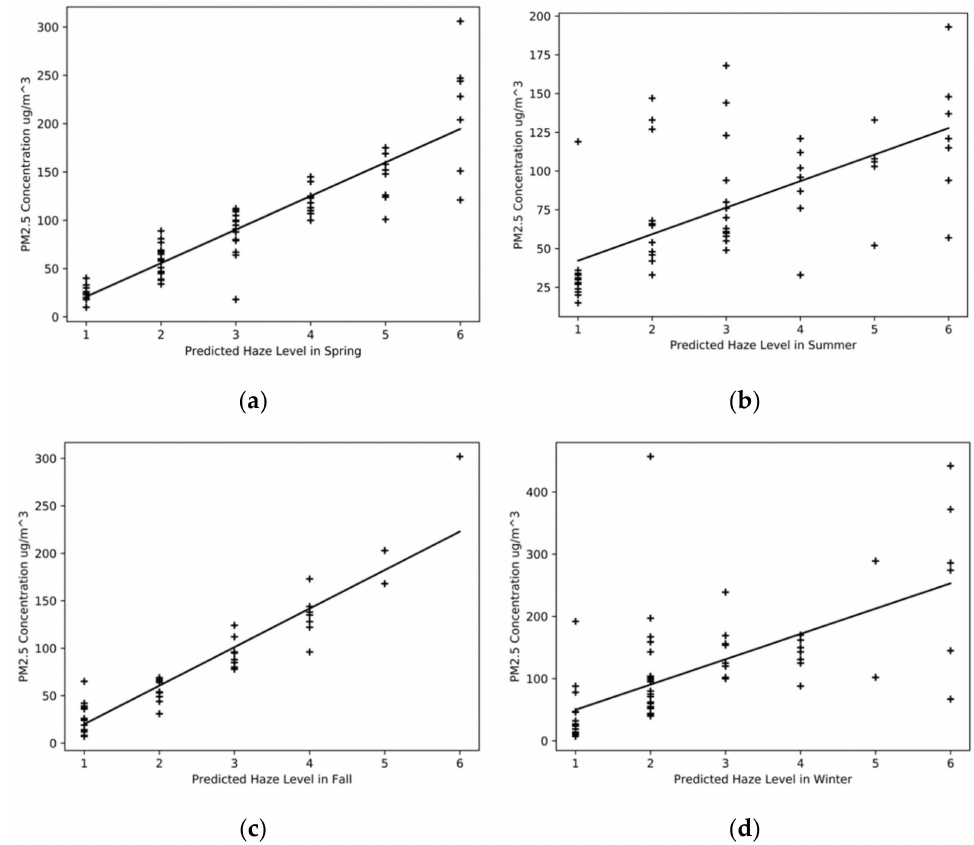
Figure 9. Linear regression between haze level using CNN and PM2.5 ( a ) Linear regression for CNN and PM2.5 in Spring; ( b ) Linear regression in Summer; ( c ) Linear regression in Fall; ( d ) Linear regression in